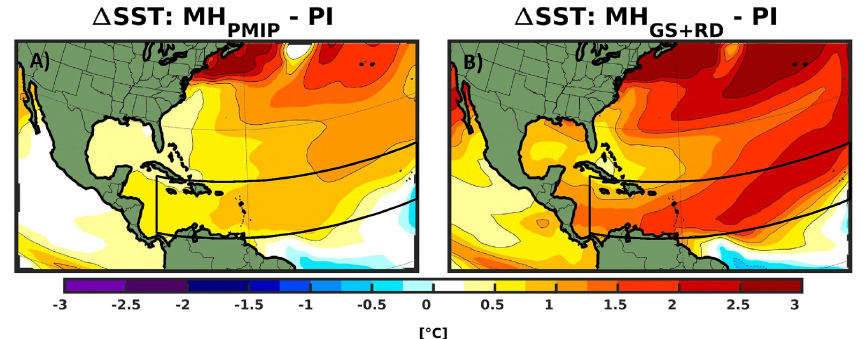
Figure A6. Climatological (JJASON) changes in SST for the (a) MH PMIP and (b) MH GS + RD experiments relative to PI. The black box shows the approximate present-day MDR. Only values that are significantly different at the 5% level using a local (grid-point) t test are shaded. The contour lines follow the color-bar scale (dashed, negative anomalies; solid, positive anomalies); the 0 line is omitted for clarity.